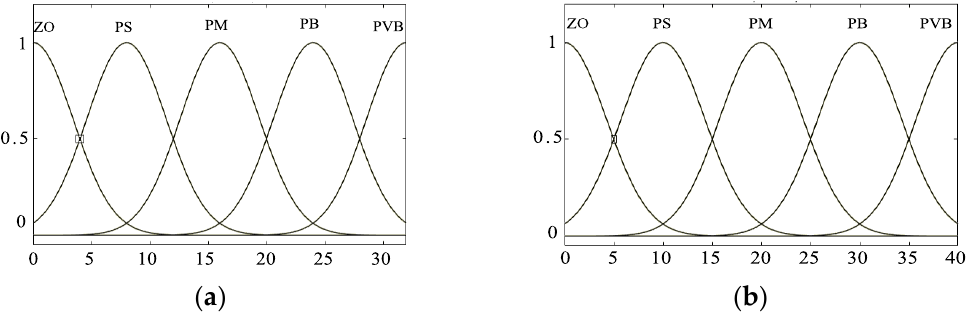
Figure 4. Membership function of input value: ( a ) the front wheel angle | δ f |; ( b ) the vehicle speed u .